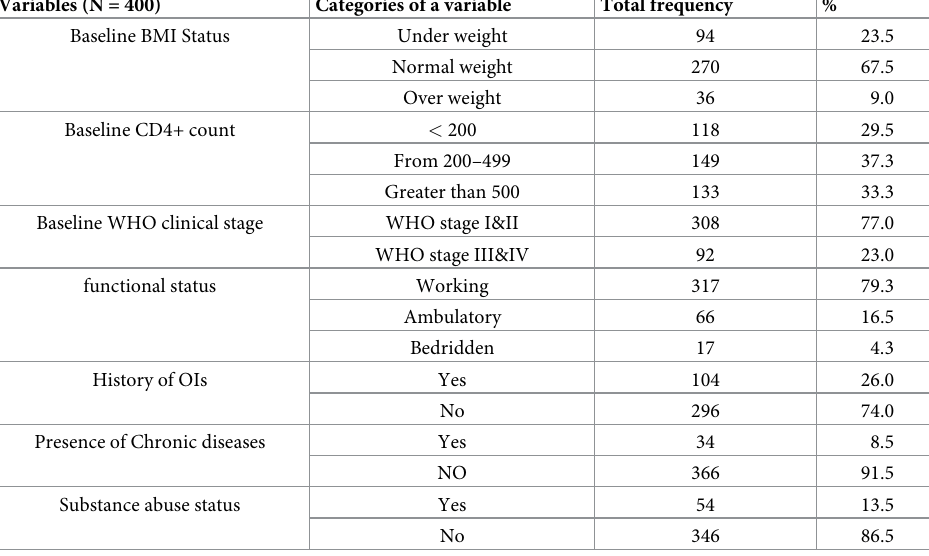
Table 2. Clinical and behavioral characteristics of adults receiving ART at public health institutions in Bahir Dar city, Northwest Ethiopia, 2022.